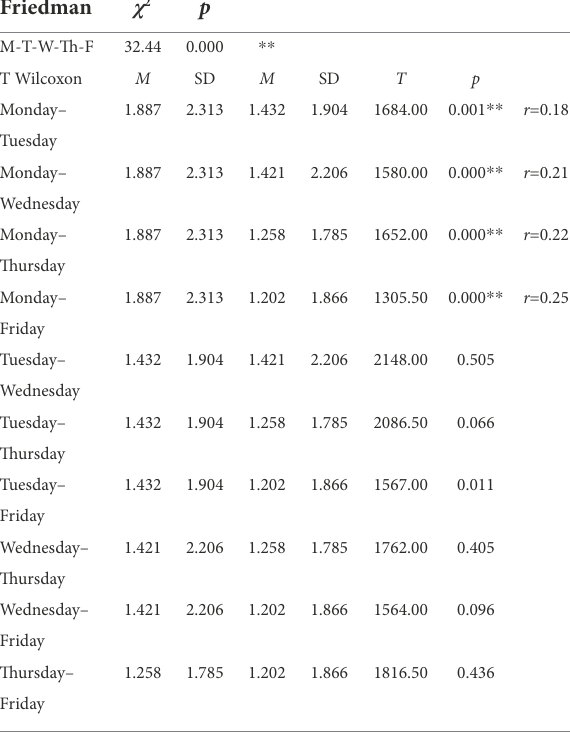
TABLE 6 Results of Friedman’s test and multiple a posteriori contrasts of home conflicts in the evenings during weekdays. Comparison parents weekdays